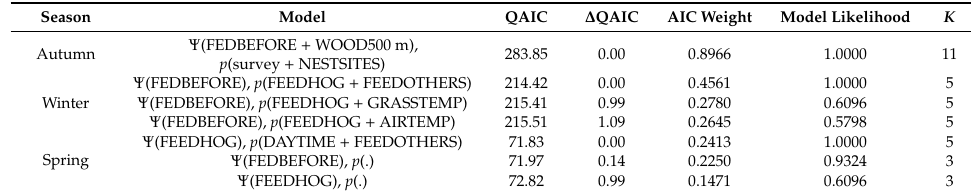
Table 3. A summary of the top-ranking models ( Δ QAIC < 2) produced in single-season occupancy analyses. Seasons are illustrated in Figure 2.